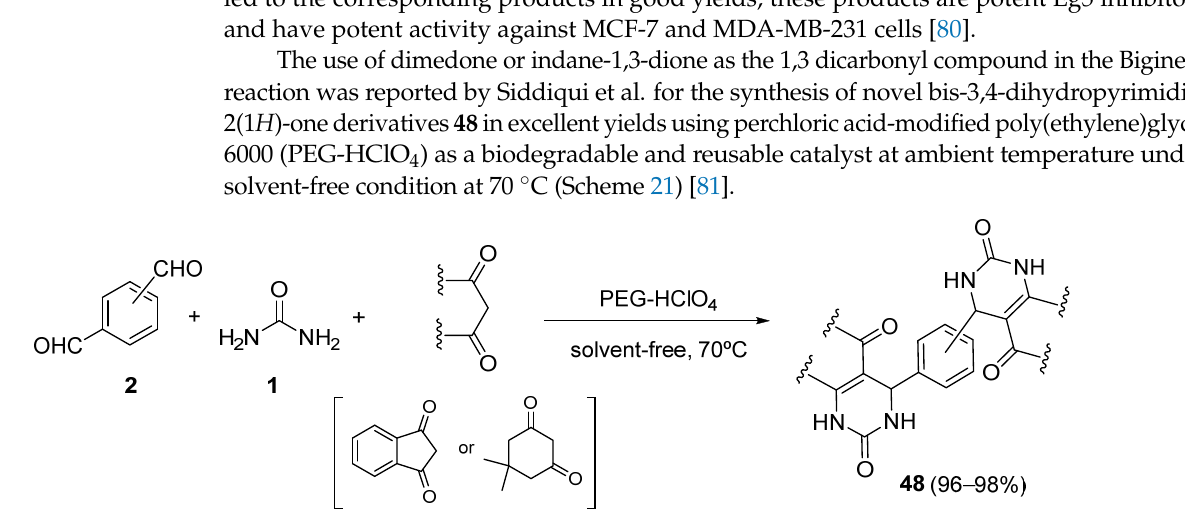
Scheme 21. Synthesis of bis-DHPMs 48 from dimedone or indane-1,3-dione as the keto ester com-